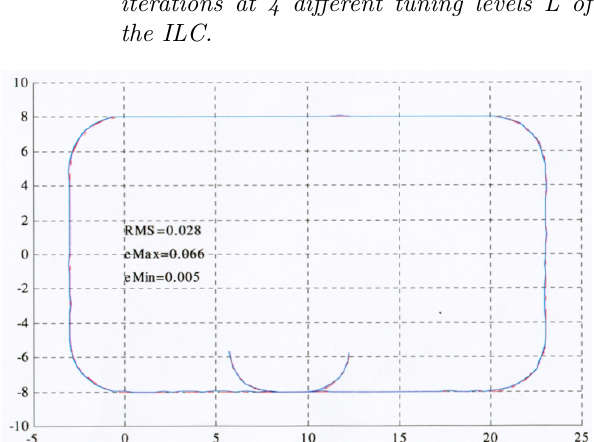
Figure 13: Iterative Learning Control (ILC) for laser- cutting of rectangular holes. The obtained path after ILC has been performed (numbers in